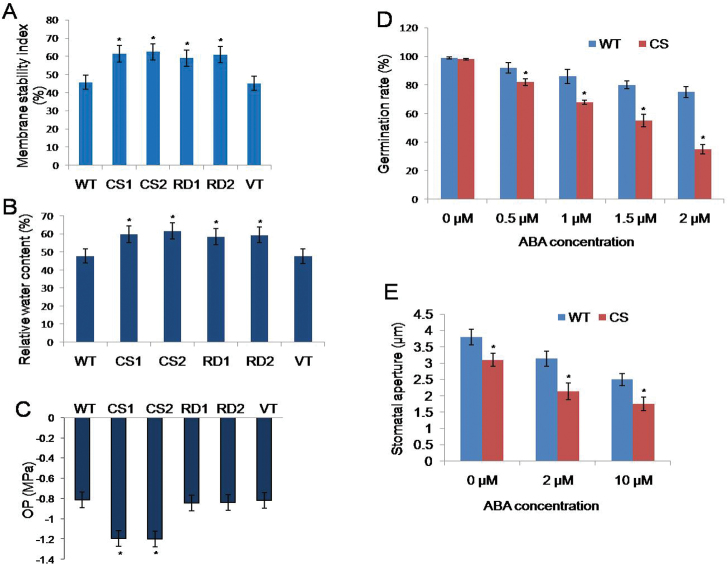
Physiological characterization of CcCDR-transgenic plants. (A) Cell membrane stability measurement of transgenics, WT, and VT seedlings treated with 150 mM NaCl. (B) Comparison of relative water contents of detached rosettes of controls and transgenic plants. (C) Measurement of osmotic potential of transgenic lines, WT, and VT plants under well-watered conditions. (D) Germination rates of transgenic (CS) and WT seeds on ABA-containing medium. Seeds were placed on MS medium containing 0, 0.5, 1.0, 1.5, or 2.0 μM ABA and the germination rate was calculated after 7 d. Seeds were considered to have germinated when the radicle tip had expanded by 1mm. (E) Size of stomatal apertures of transgenics (CS) and the WT after ABA treatment. Leaves of transgenics and the WT were treated with ABA- (2.0 μM and 10.0 μM) containing solution for 2h. Stomatal apertures in epidermal peels were observed under a confocal microscope and 50 stomatal apertures were measured for each treatment. The mean and SE from three independent experiments are shown. For each treatment, 20 seedlings were used. * indicates significant differences in comparison with the WT at P<0.05. WT, wild type; VT, vector transformed; CS1 and CS2, 35S transgenic lines; RD1 and RD2, rd29A transgenic lines. (This figure is available in colour at JXB online.)